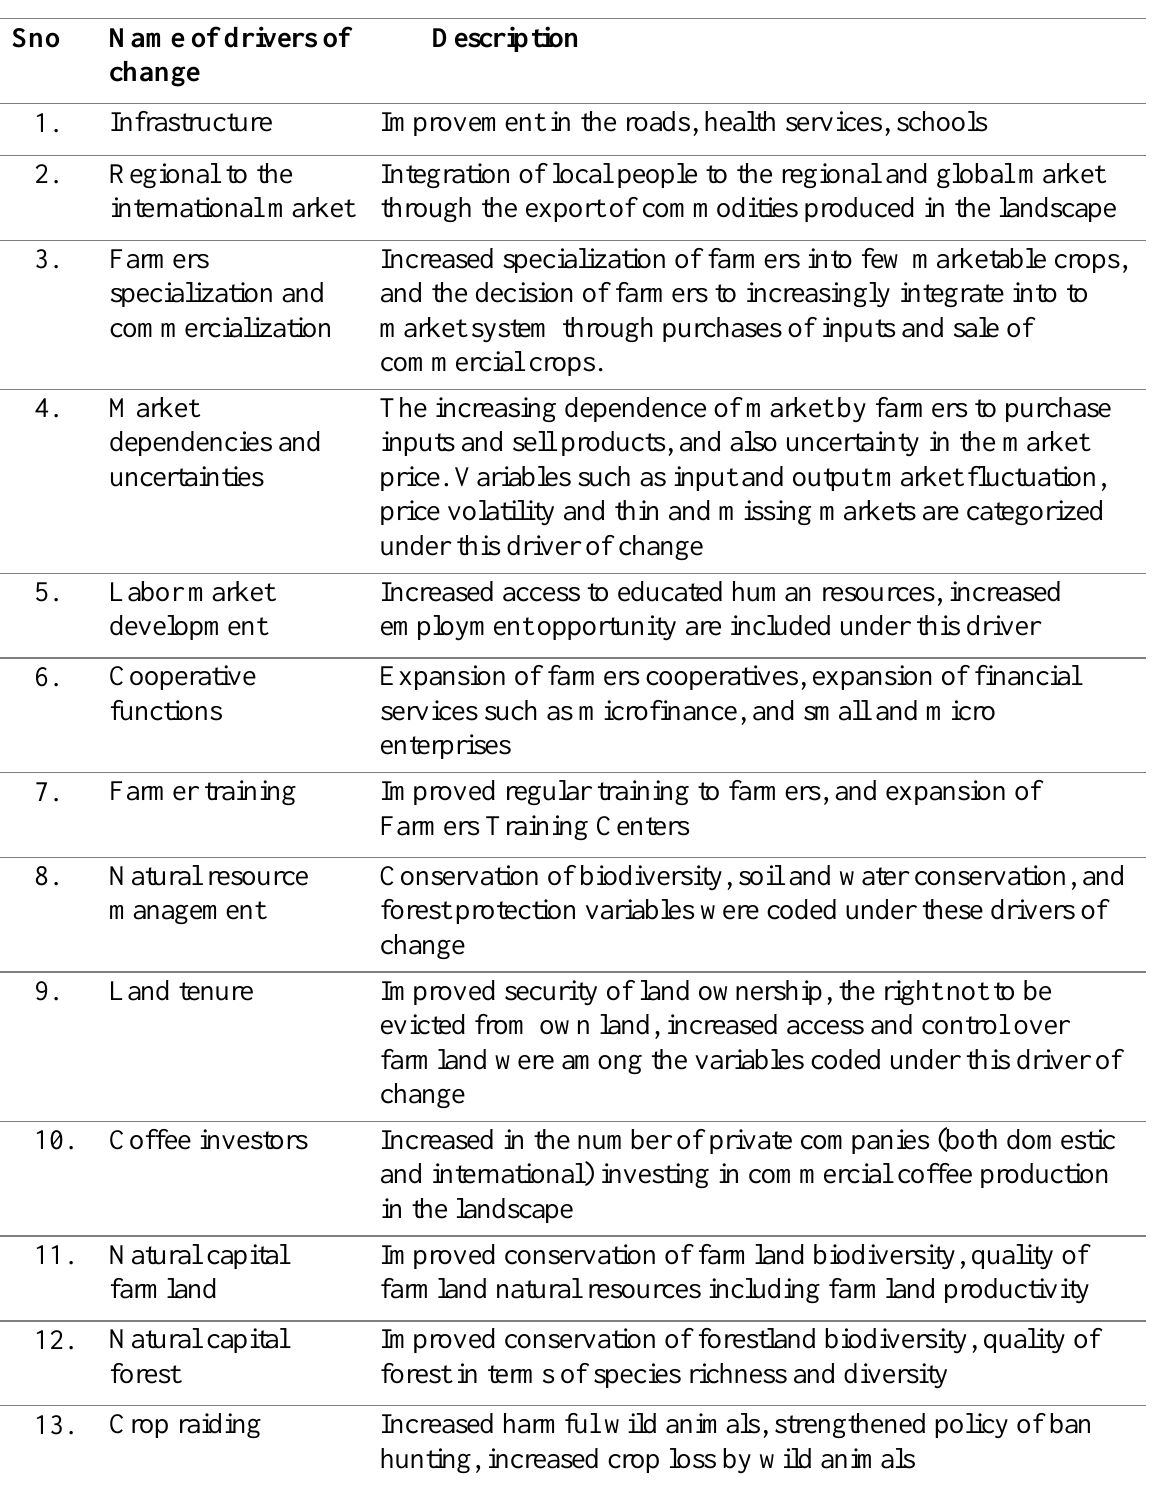
Table A1.3. Description of the main drivers of change included in the causal loop diagram